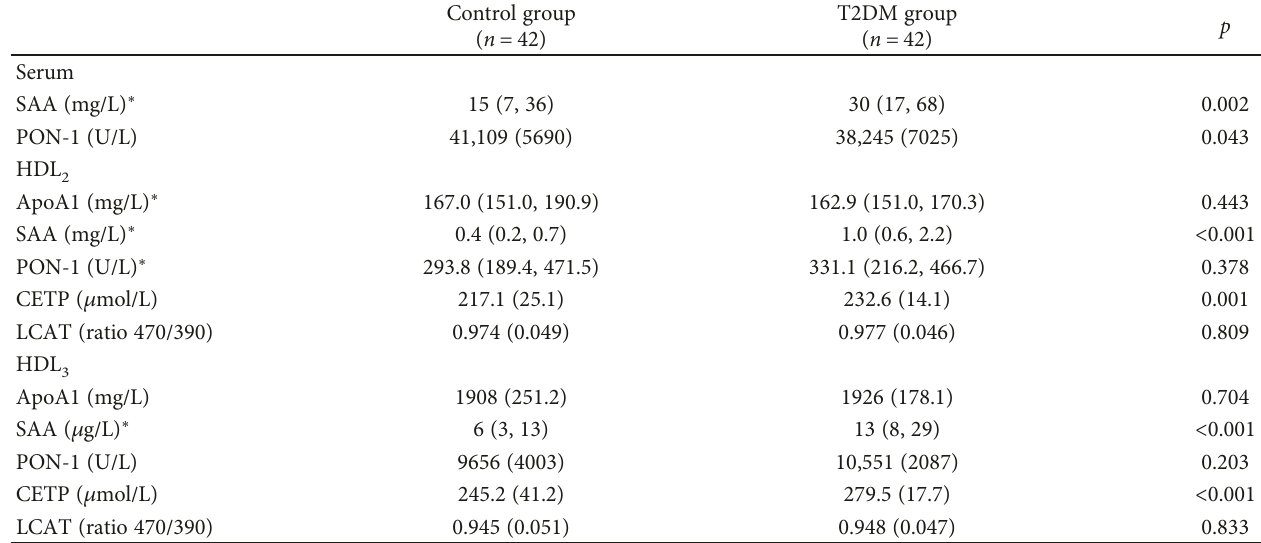
Table 2: Nonstandardised results.